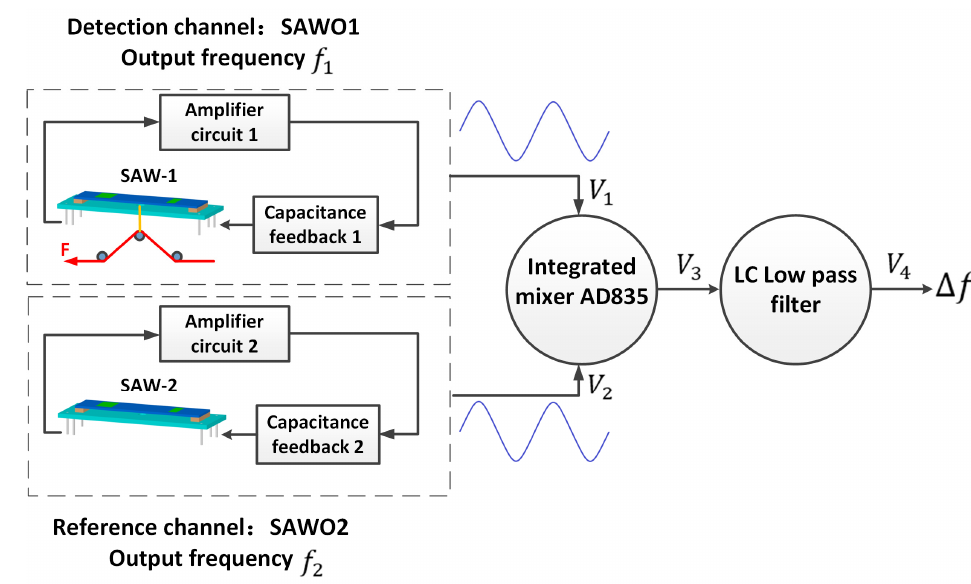
Figure 1. The schematic of SAW yarn tension sensor with dual differential circuit system. In Figure 1, SAWO1 generate the sine wave signal V 1 , and the output frequency is f 1 . SAWO2 create the sine wave signal V 2 , and the output frequency is f 2 . Signals V 1 and V 2 entered into the integrated mixer AD835, and the signal output frequency is V 3 , where V 3 is the frequency sum and frequency difference of V 1 and V 2 ( V 1 ± V 2 ). After the mixed output, signal V 3 is input to the LC low pass filter, the frequency sum of f 1 and f 2 are filtered out, and only the frequency difference of f 1 and f 2 is